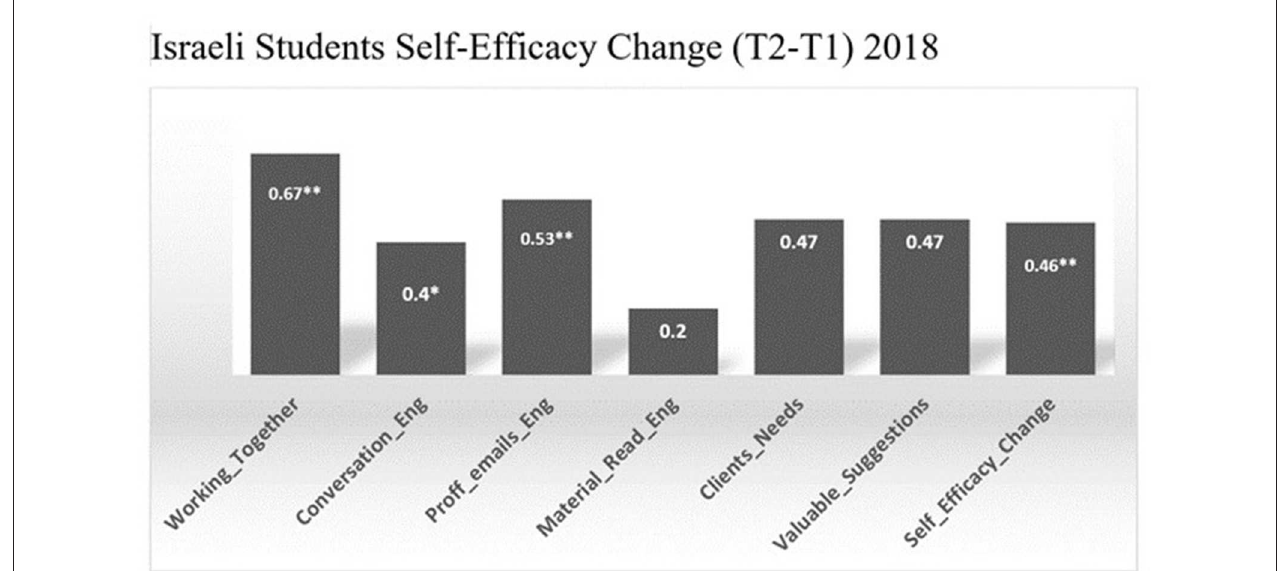
FIGURE 3 | Israeli students self-efficacy changes (T2–T1) 2018. * p < 0.05; ** p < 0.01.